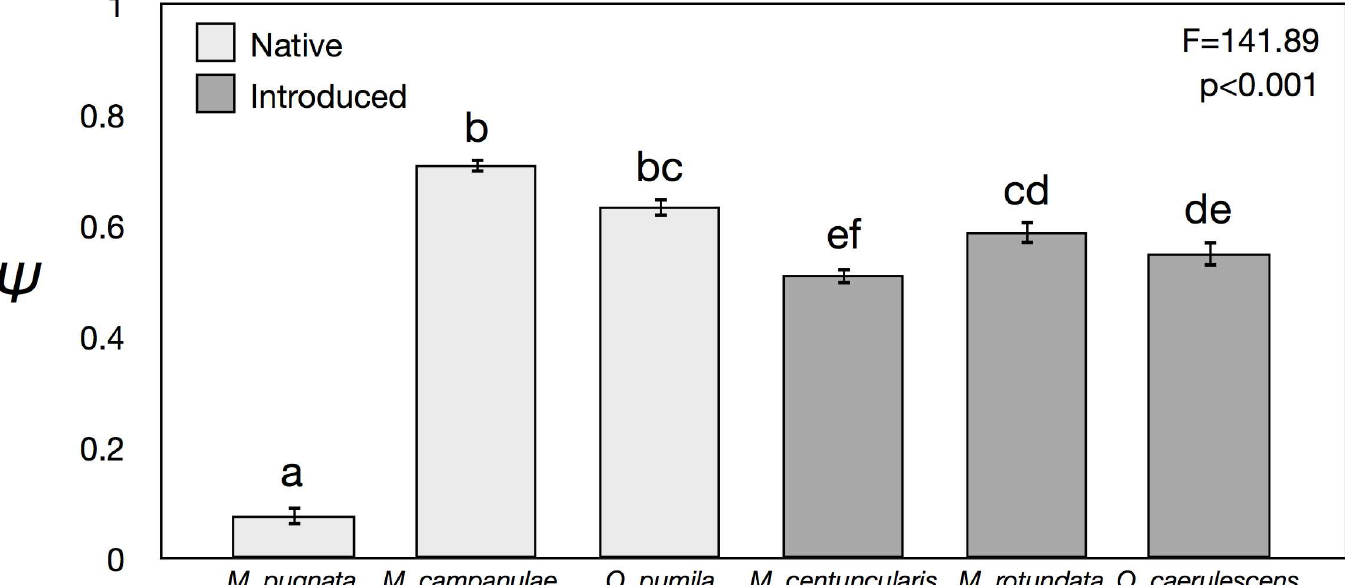
Fig 2. Occupancy probability scores for each of the six species using the model equation Ψ (site), p (.). Significantdifferences ( α = 0.05) are indicated alphabetically. Native species in pale grey and introducedspecies in darker